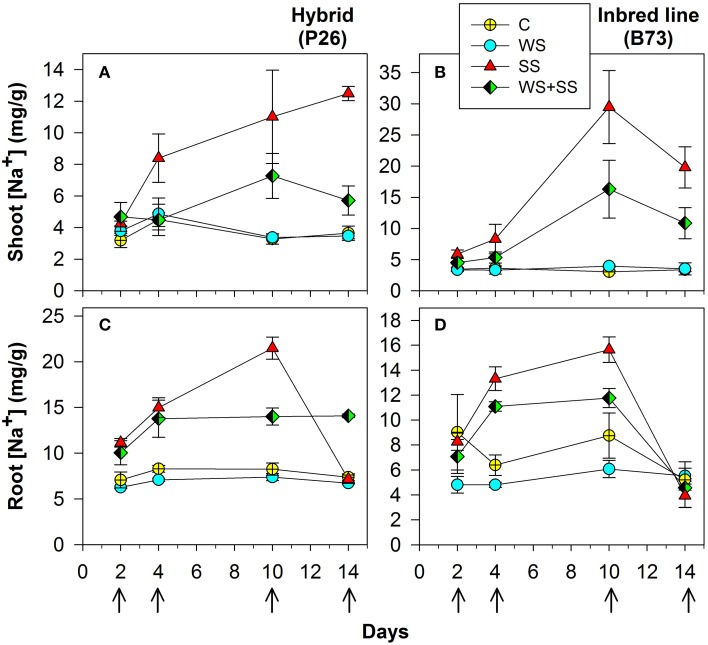
Shoot (A) and (B), and roots (C) and (D) Na+ concentration in maize plantlets of the inbred line B73 and hybrid P26 grown for 10 days under control (C), drought (WS), salinity (SS), or the combination of drought and salinity (WS+SS) and after 4 days of recovery from the stresses. Values represent means ± SE (n = 3). Arrows represent sampling times throughout the experimental period.